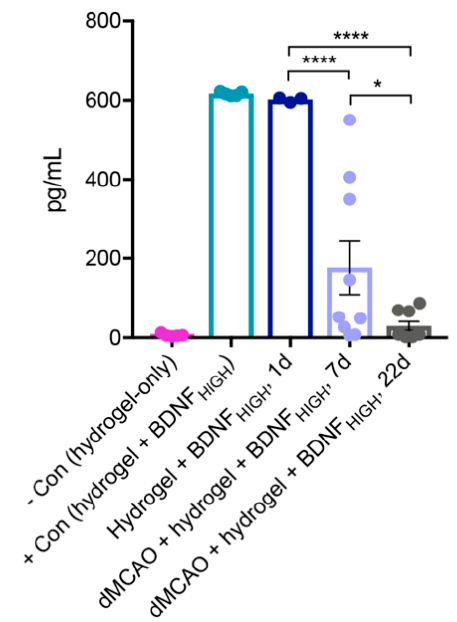
Figure 1. In vivo determination of brain-derived neurotrophic factor (BDNF) release from hydrogel. ELISA for BDNF content determination in hydrogel—negative control ( − con), hydrogel + BDNF HIGH —positive control (+ con), hydrogel + BDNF HIGH at one day after implantation and distal middle cerebral artery occlusion (dMCAo) + hydrogel + BDNF HIGH at 7 and 22 days after implantation. BDNF is continuously and significantly released from the hydrogel over time with majority of the BDNF being released by 22 days post implantation. − con (hydrogel-only) n = 1; +con (hydrogel + BDNF HIGH ) n = 1; hydrogel + BDNF HIGH , 1 day, n = 1; dMCAo + hydrogel + BDNF HIGH , 7 days, n = 3; dMCAo + hydrogel + BDNF HIGH , 22 d, n = 3. Error bars indicate the mean ± SEM; * p < 0.05, **** p < 0.0001.